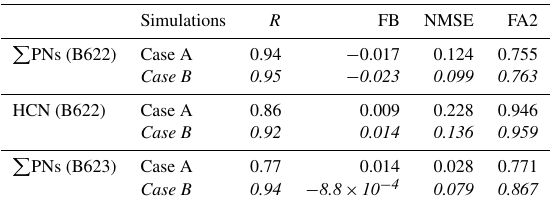
Table 4. Indices to evaluate the model performances. R is the corre- lation coefficient, FB is the fractional bias, NMSE is the normalised mean squared error and FA2 the factor of 2. See the text for a de- scription of these indices. In italic are the results obtained including the pressure to the